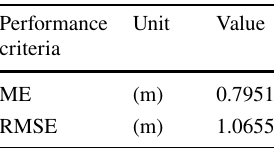
Table 5 The results of performance criteria for groundwater head